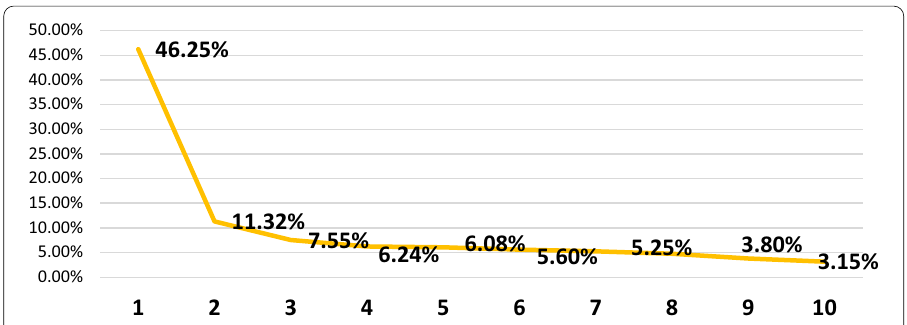
Fig. 16 Distributions of the severity of the highest ranking challenge